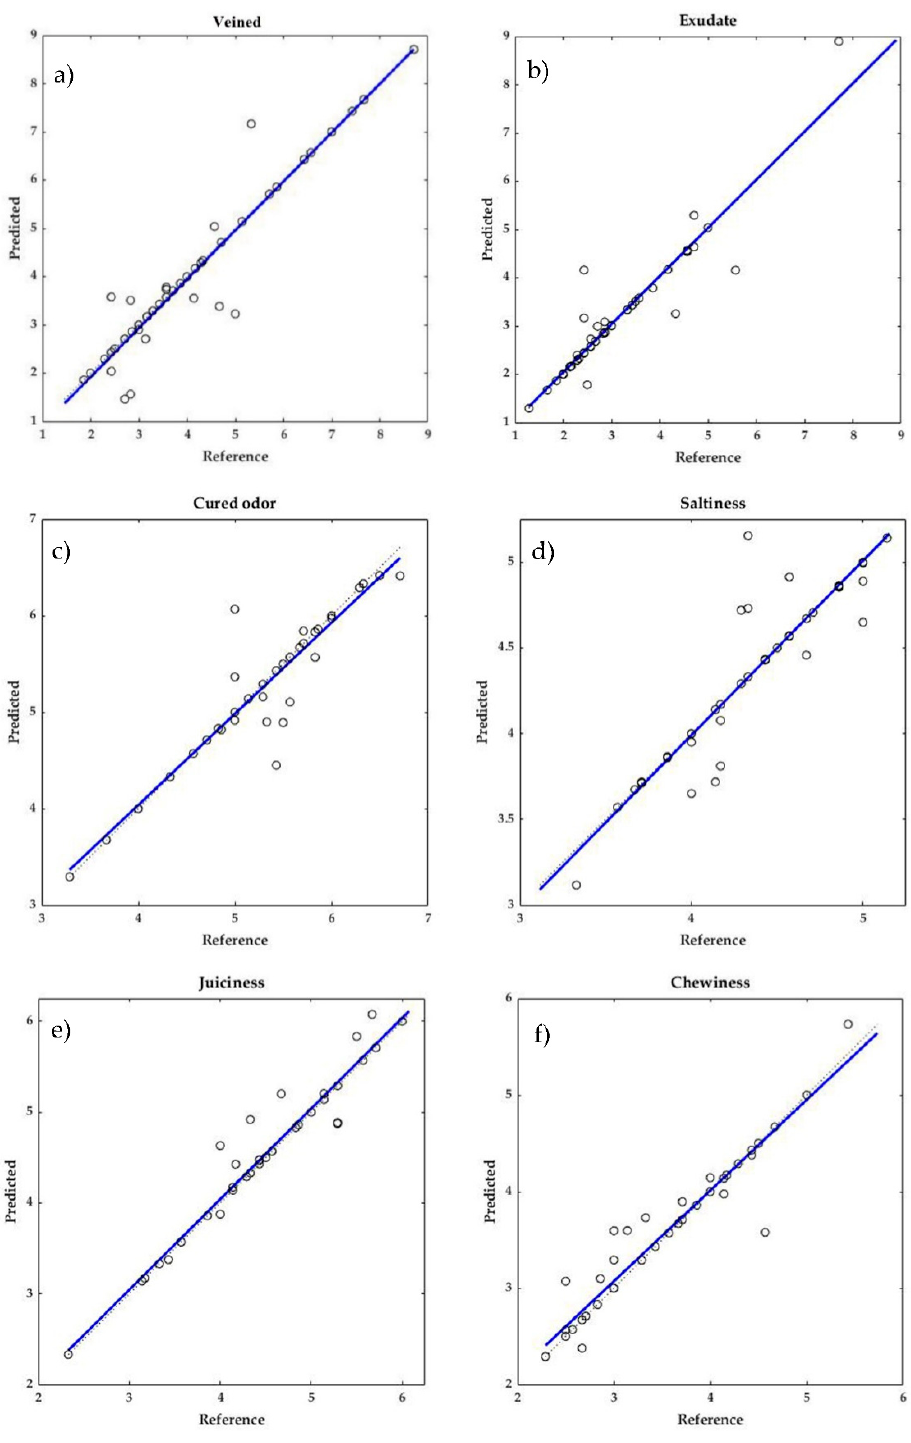
Figure 5. Reference vs. predicted values for ( a ) veined, ( b ) exudate, ( c ) cured odor, ( d ) saltiness, ( e ) juiciness, and ( f ) chewiness.